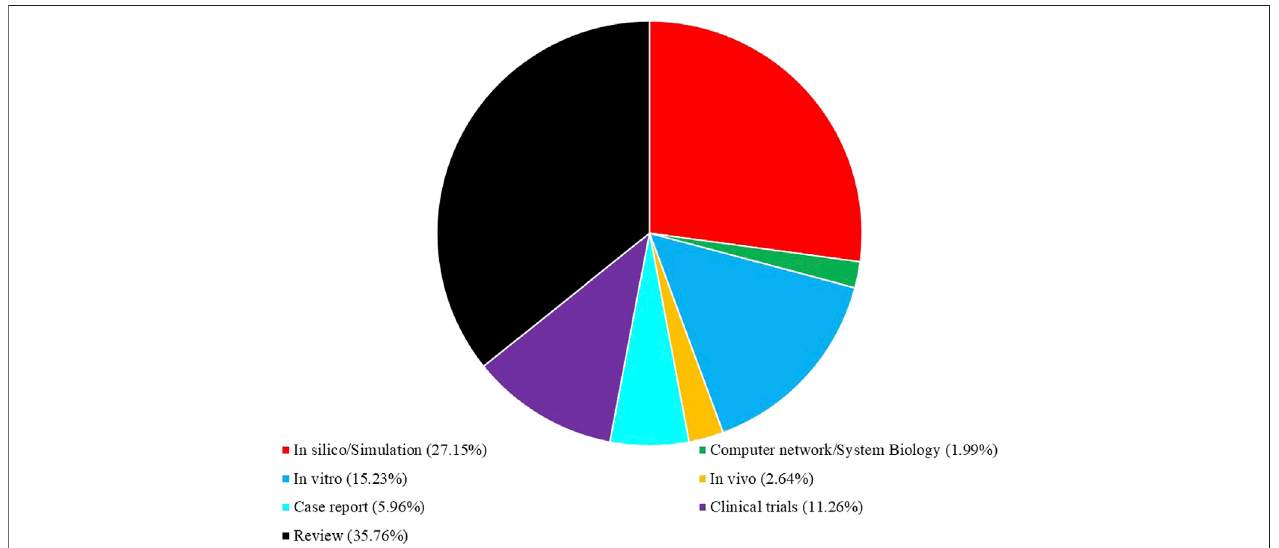
FIGURE 1 | Present proportion (%) of cited literature related to COVID-19 and curcumin according to their categories in this review article.